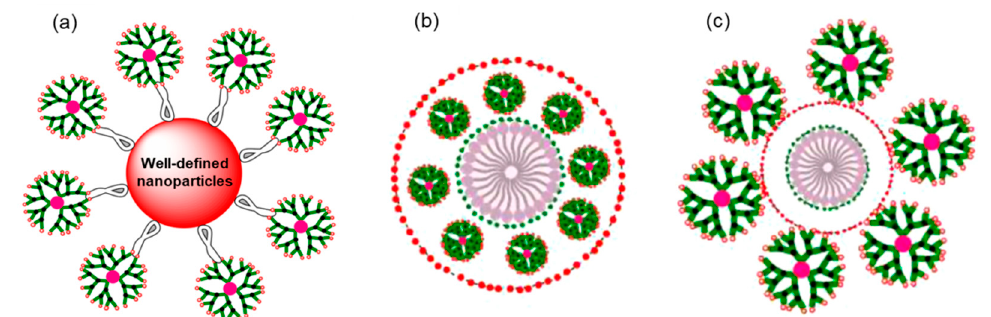
Figure 50. ( a ) Dendrimer-nanohybrids formed by grafting various dendrimers to discrete, well-defined nanoparticles (i.e., gold nanoclusters, quantum dots, carbon nanotubes, etc.), ( b ) Dendrimer encapsulated liposome and ( c ) dendrimer adsorbed onto a liposome. Adapted with permission from [195] with permission of Elsevier.